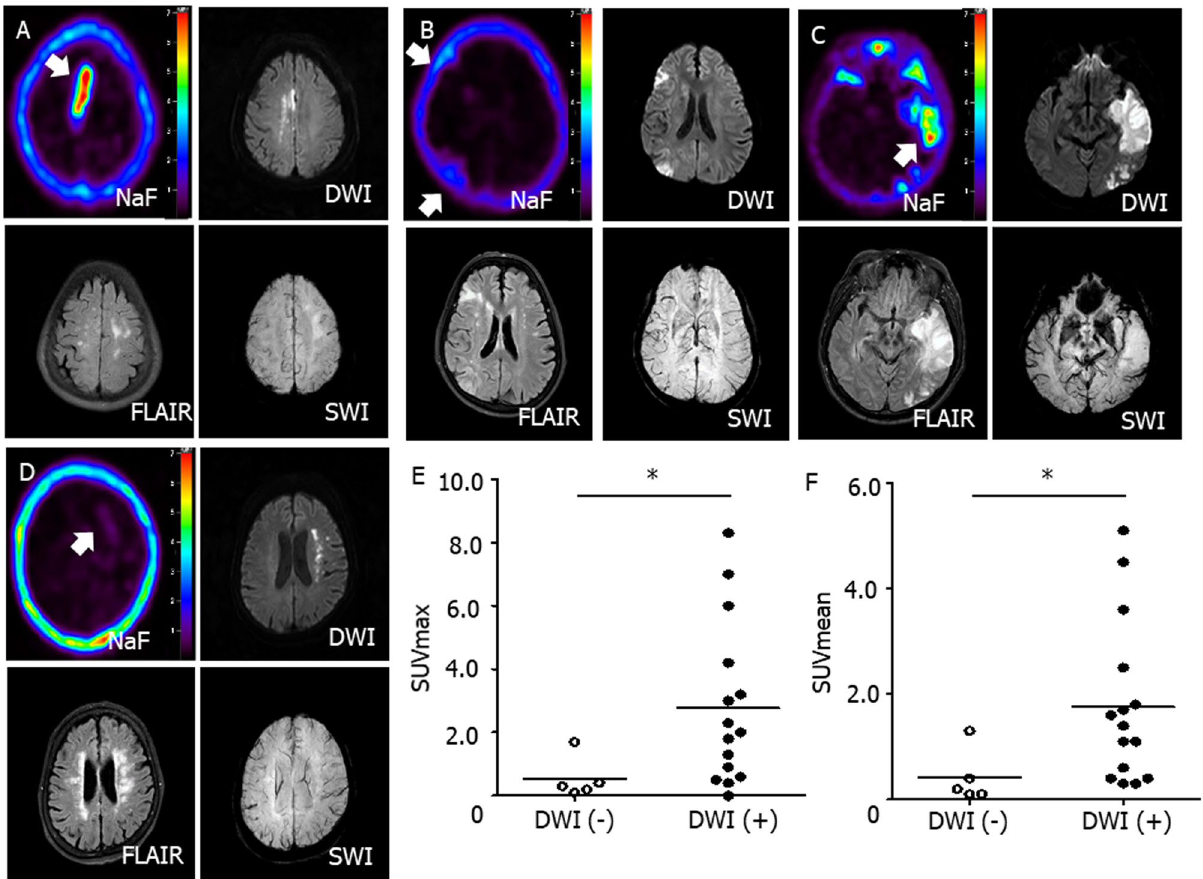
Figure 1. Representative brain imaging and NaF uptake intensity according to infarction lesion. Representative 18 F-sodium fluoride (NaF) positron emission tomography and brain MR imaging demonstrated that NaF uptake is correlated with acute ischemic lesions from diffusion weighted images from four cerebral infarction patients ( A – D , white arrows). The comparison of NaF uptake intensity between the diffusion-negative and diffusion- positive lesions revealed that both maximum (2.0 [0.60–4.2] versus 0.20 [0.10–0.40], p = 0.021, Mann–Whitney U test, E ) and mean (1.4 [0.40–2.5] versus 0.30 [0.20–0.40], p = 0.018, Mann–Whitney U test, F ) standardized uptake values were elevated among the infarction lesions with DWI ( +). DWI stands for diffusion-weighted image; FLAIR, fluid attenuated inversion recovery; SWI, susceptibility-weighted image; SUVmax, maximum standardized uptake value; SUVmean, mean standardized uptake value; *, statistically significant at p <